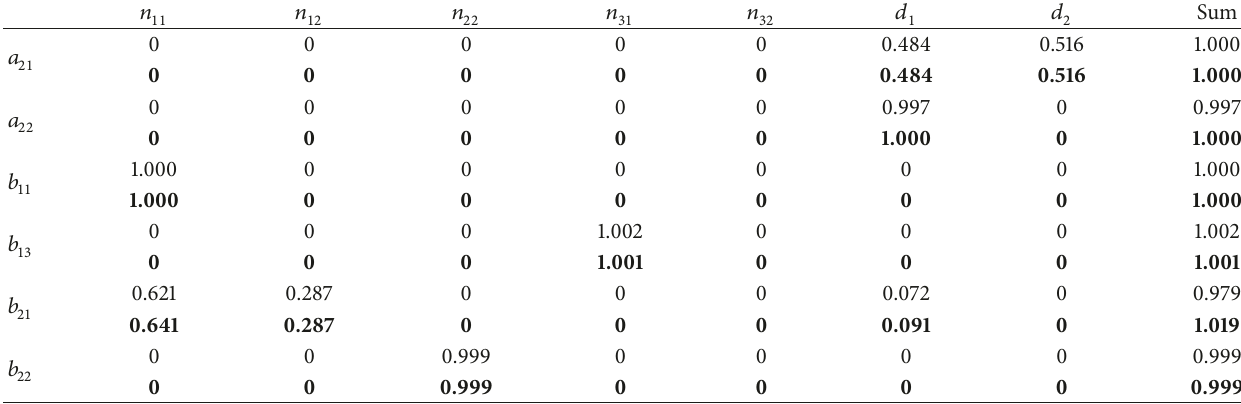
Table 11: First-order and total sensitivity indices, ARX to SS